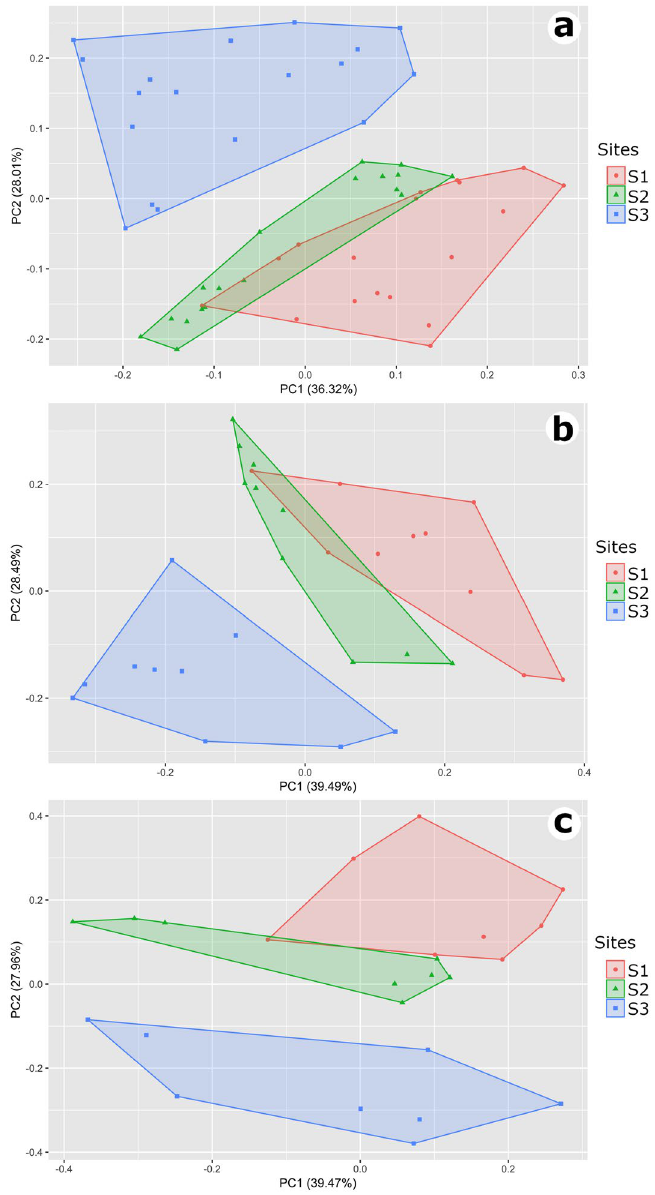
Figure 1. Multivariate environmental space at GANM. Principal Component Analysis for the eight environmental variables measured at each sampling site (S1, S2 and S3) for 18 consecutive months. ( a ) General structure (all 18 months). ( b ) Dry season only. ( c ) Rainy season